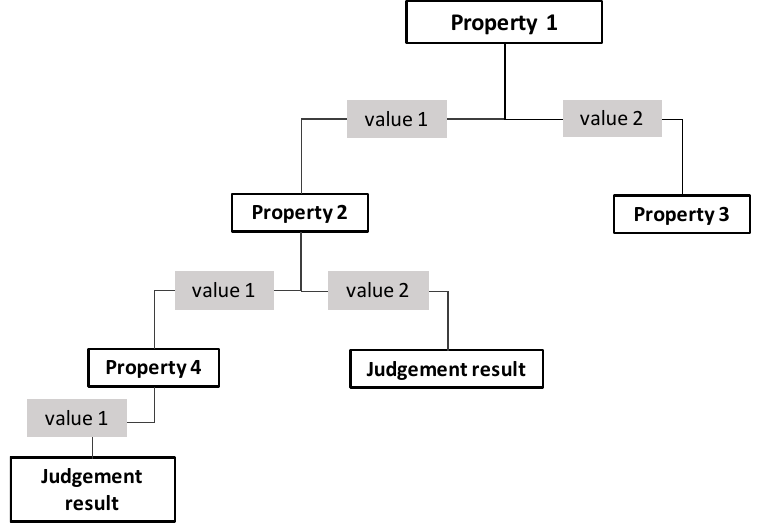
Figure 2. Schematic diagram of a decision tree.